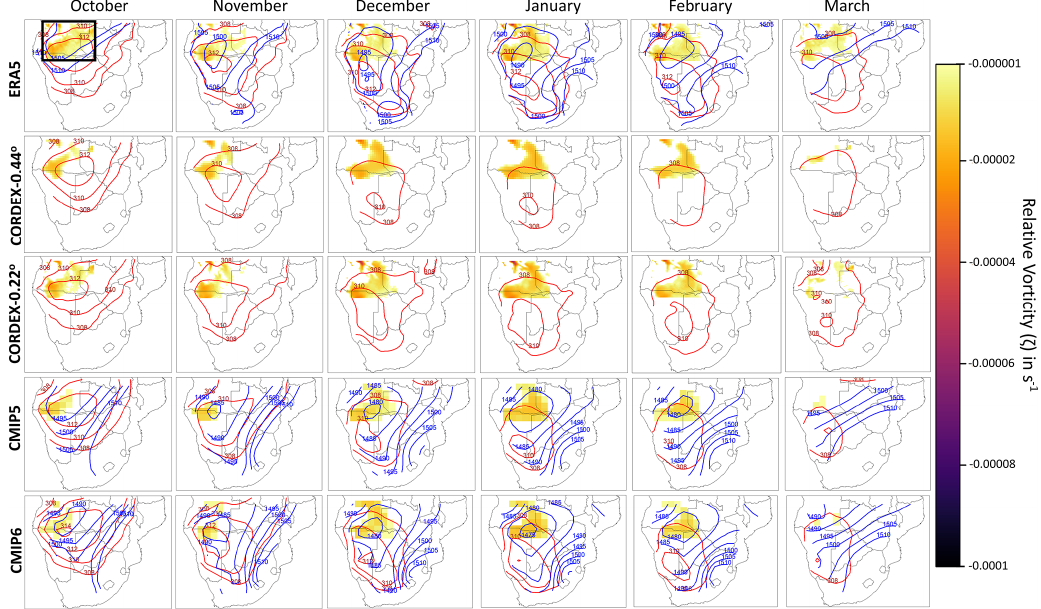
Figure 6. Monthly climatologies of the Angola Low pressure system during the rainy season for the period 1986–2005. Filled contours indicate cyclonic relative vorticity ( ζ ) for ζ < − 0.00001s − 1 over the region extending from 14 to 25 ◦ E and from 11 to 19 ◦ S. Red lines indicate the isotherms of potential temperature at 850hPa, having an increment of 2K. Blue lines indicate isoheights of the geopotential height at 850hPa, having an increment of 5m. CORDEX0.44 and CORDEX0.22 are not plotted with geopotential isoheights, because this variable was not available for CORDEX simulations. From top to bottom: ERA5, ensemble mean of CORDEX0.44 ◦ , CORDEX0.22 ◦ , CMIP5 and CMIP6 simulations. Black box indicates the region from 14 to 25 ◦ E and from 11 to 19 ◦